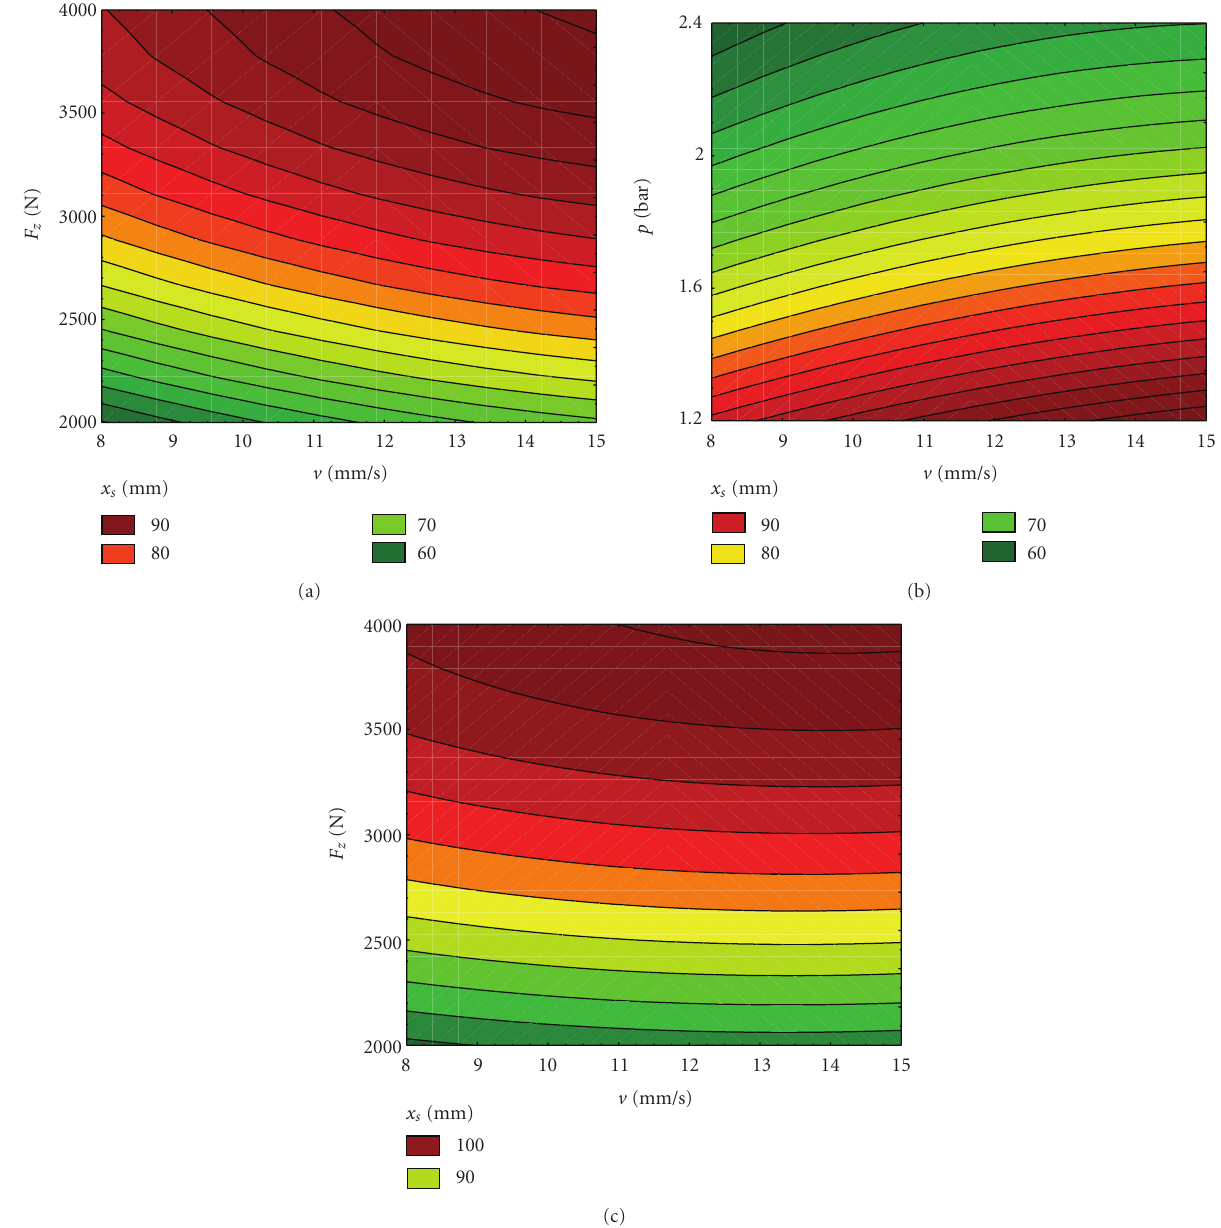
Figure 17: Examples of regression characteristics of cohesion contact length for the rolling of a slick tire in a driven mode: (a) new tire with p = 2 . 1bar = const; (b) new tire with F z = 4000 N = const; (c) worn tire with p = 2 . 1 bar = const (from